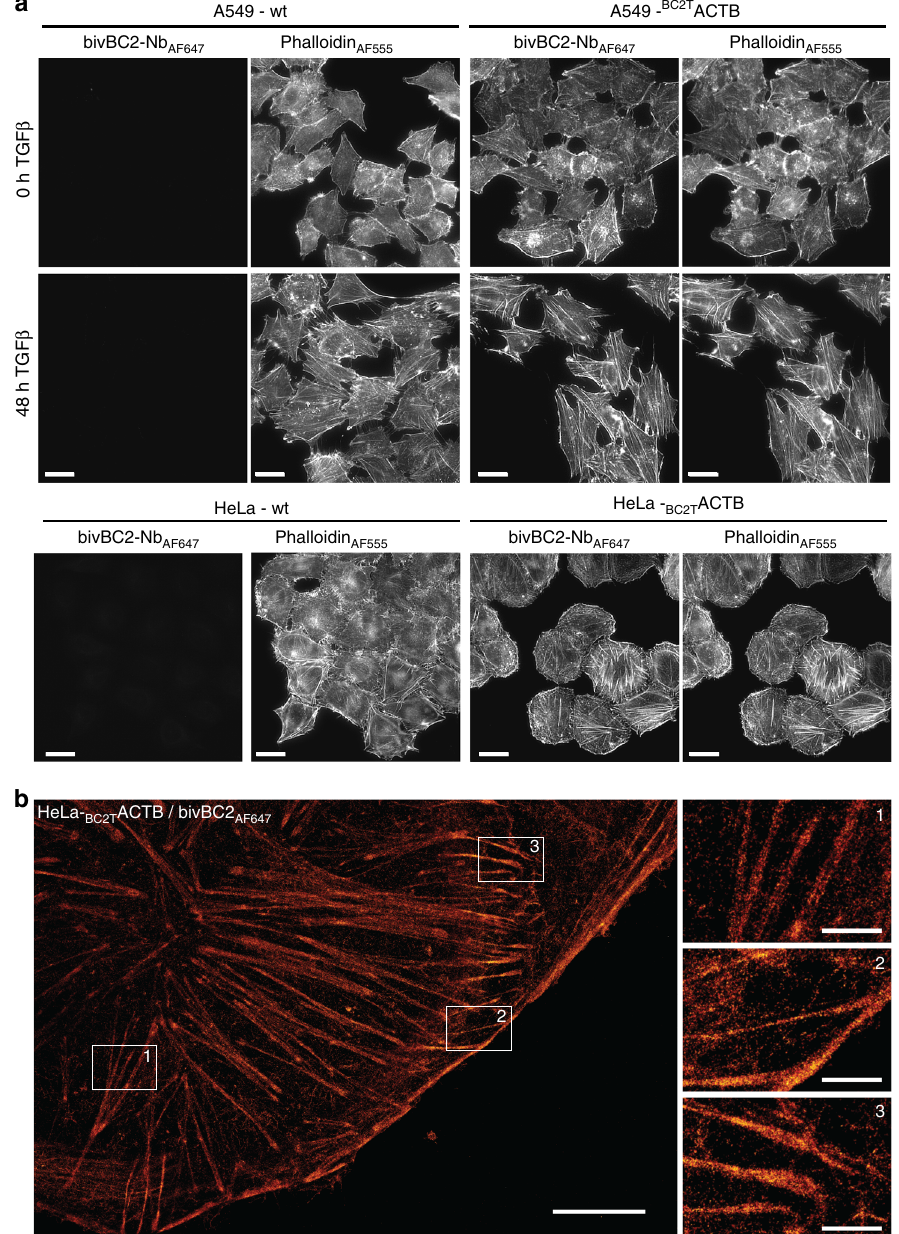
Fig. 4 Visualization of endogenously expressed BC2-tagged actin labeled with bivBC2-Nb AF647 . a Wide- fi eld images of chemically fi xed wild-type A549 and HeLa (-wt; left panel), as well as chemically fi xed A549- BC2T ACTB and HeLa- BC2T ACTB cells (right panel). Cells were either left untreated (0 h) or stimulated for 48 h with TGF β (5 ng ml − 1 ) followed by staining with phalloidin AF555 and bivBC2-Nb AF647 . Scale bars, 25 µ m. b dSTORM image of a representative HeLa- BC2T ACTB cell. Scale bars, image 5 µ m, insets 1 µ m. Image reconstruction details are given in Methods section. Imaging sequence taken from raw data acquisition can be found in Supplementary Movie 5, assessment of AF647 photophysics under dSTORM imaging conditions can be found in Supplementary Fig.